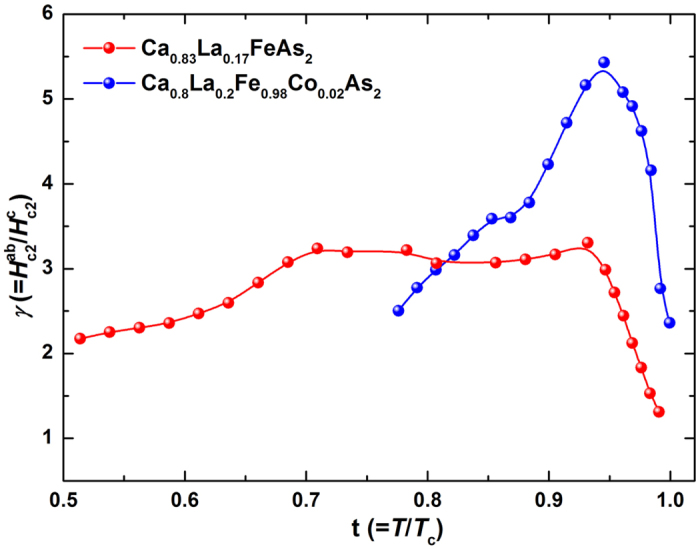
The anisotropic parameter γ versus the reduced temperature T/Tc for Ca0.83La0.17FeAs2 (red circles) and Ca0.8La0.2Fe0.98Co0.02As2 (blue circles) single crystals.